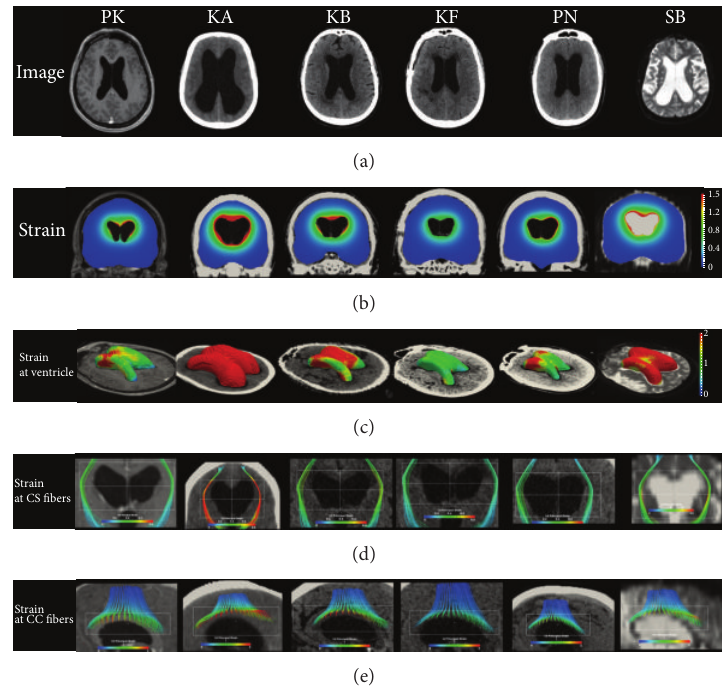
Figure 2: Overview of the 6 patients at their preoperative stages. Each row from top to bottom represents the medical images used for nonlinear image registration from which the strain level was quantified in the entire brain, and the calculated strain levels are illustrated at coronal sections and the ventricular walls. At bottom the strain level at CS and CC fiber tracts is presented.